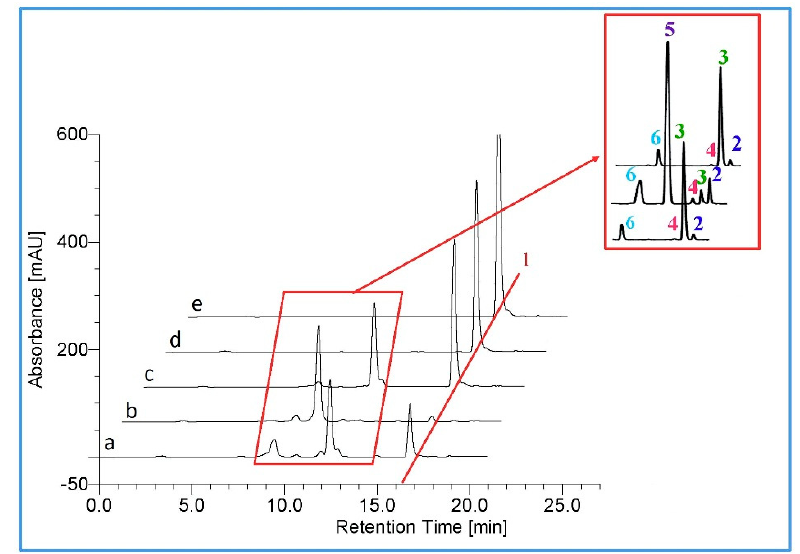
Figure 3. ( a ) HPLC chromatogram of testosterone; ( b – e ) testosterone incubation with empty vector, M01A82W, M01A82WS72I and M11A82W, respectively. Peak 1 is the testosterone standard. Peaks 2, 3,